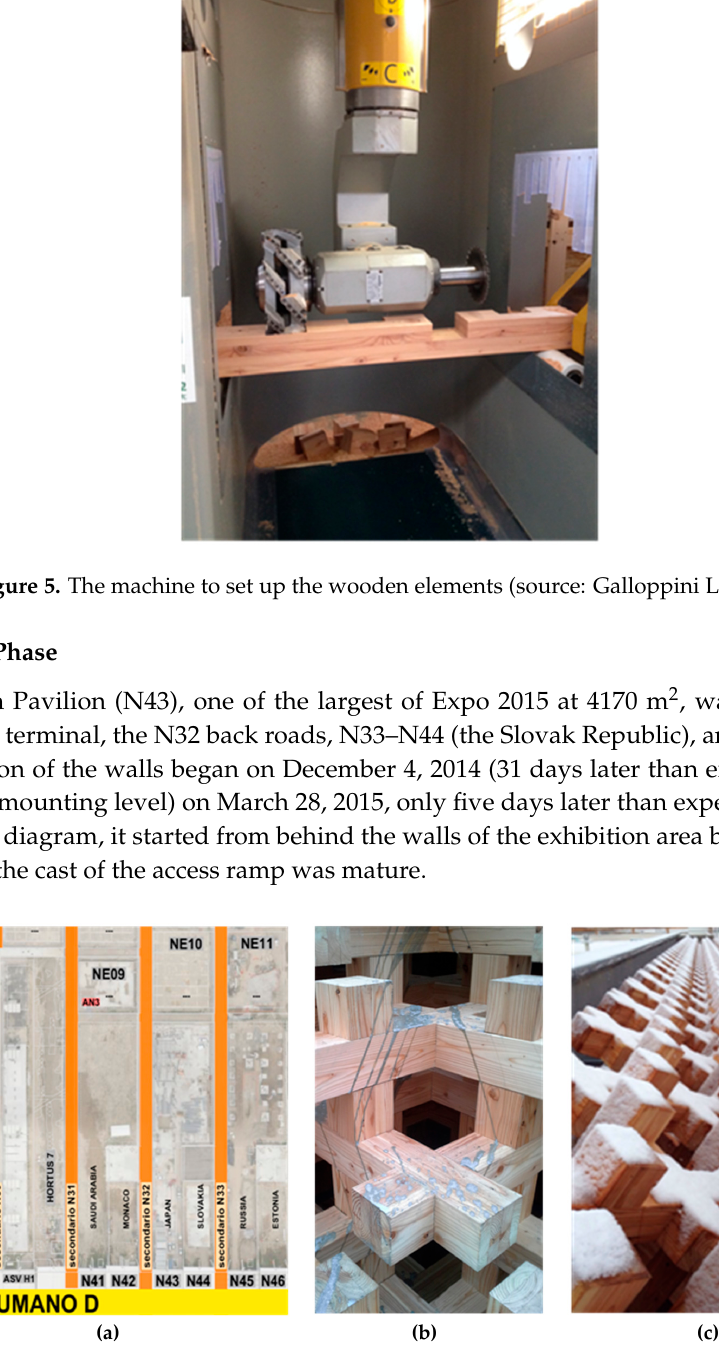
Figure 6. Location of the Japan Pavilion ( a ); effect of dust ( b ) and snow ( c ) on the wooden elements.